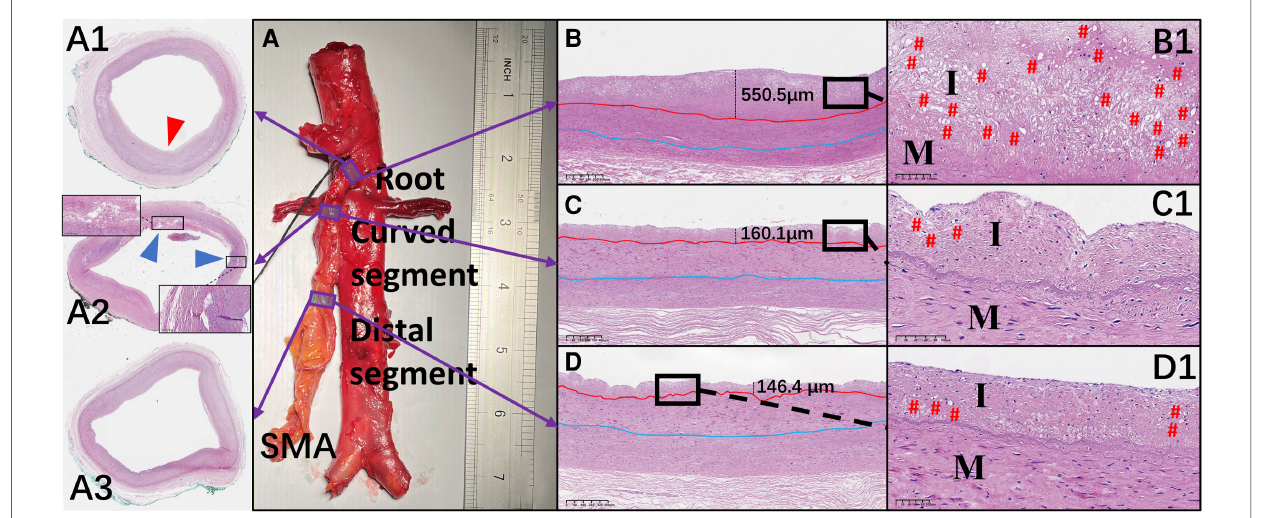
FIGURE 5 Representative images of hematoxylin and eosin – stained sections of the superior mesenteric artery (SMA) wall and comparison of the mean thickness of each layer of the vascular wall in the different regions of the SMA. ( A – D and A1 – D1 ) Hematoxylin and eosin staining of the wall located at the root ( A1 ), curved segment ( A2 ), and distal end ( A3 ) of the SMA. Thickening of the intima (red arrow) and translamellar mucoid extracellular matrix accumulation (blue arrows) can be observed. ( B – D ) The thickness of each intima is shown. ( B1 – D1 ) Local magni fi cation of the images in B – D . # represents the location of foam cells. I, intima; M,